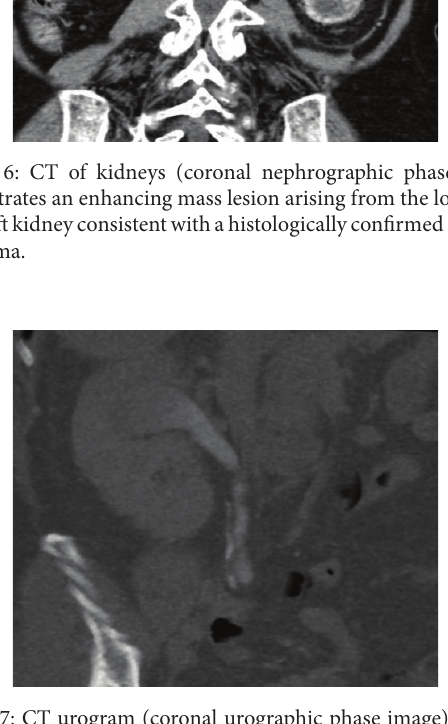
Figure 7: CT urogram (coronal urographic phase image) demon- strates a filling defect in the upper moiety of a duplex right kidney. This was histologically confirmed to be urothelial cell carcinoma following ureteroscopy and